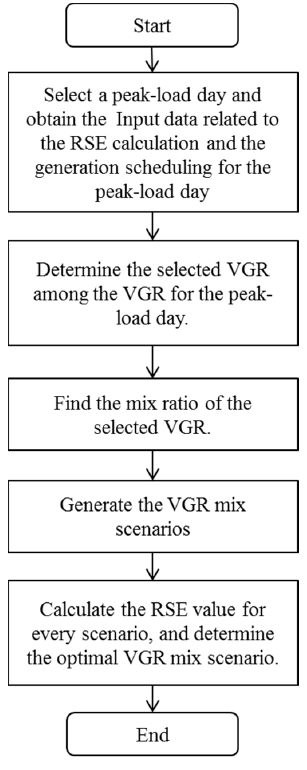
Figure 2. Procedure to find the VGR optimal mix.